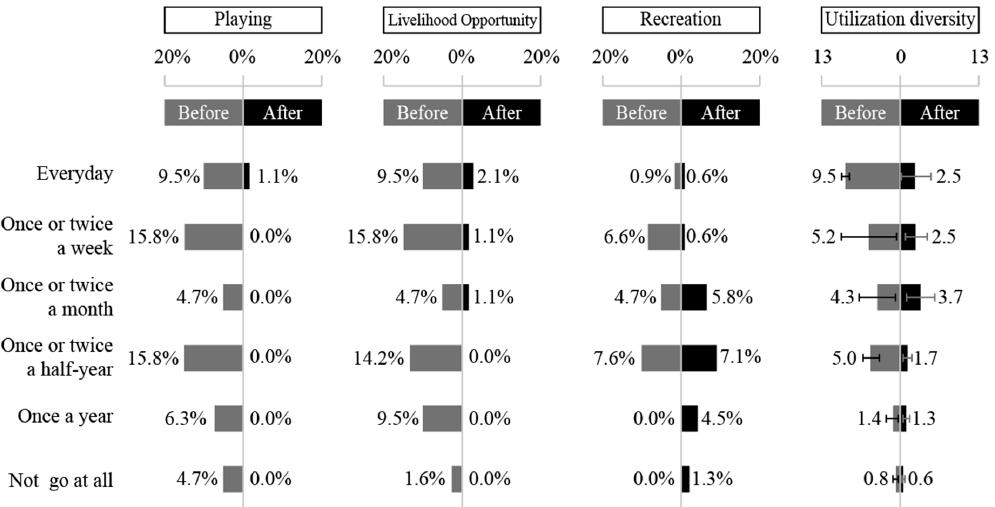
Figure 10. Ratio of answers to “no change in the Fukushima-gata lagoon before and after the reclamation project”.